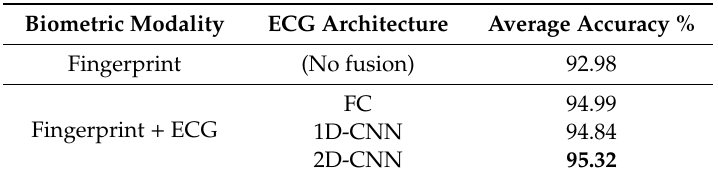
Table 5. Average accuracy of three proposed fusion architectures and the fingerprint branch net. The reported results are achieved on the customized